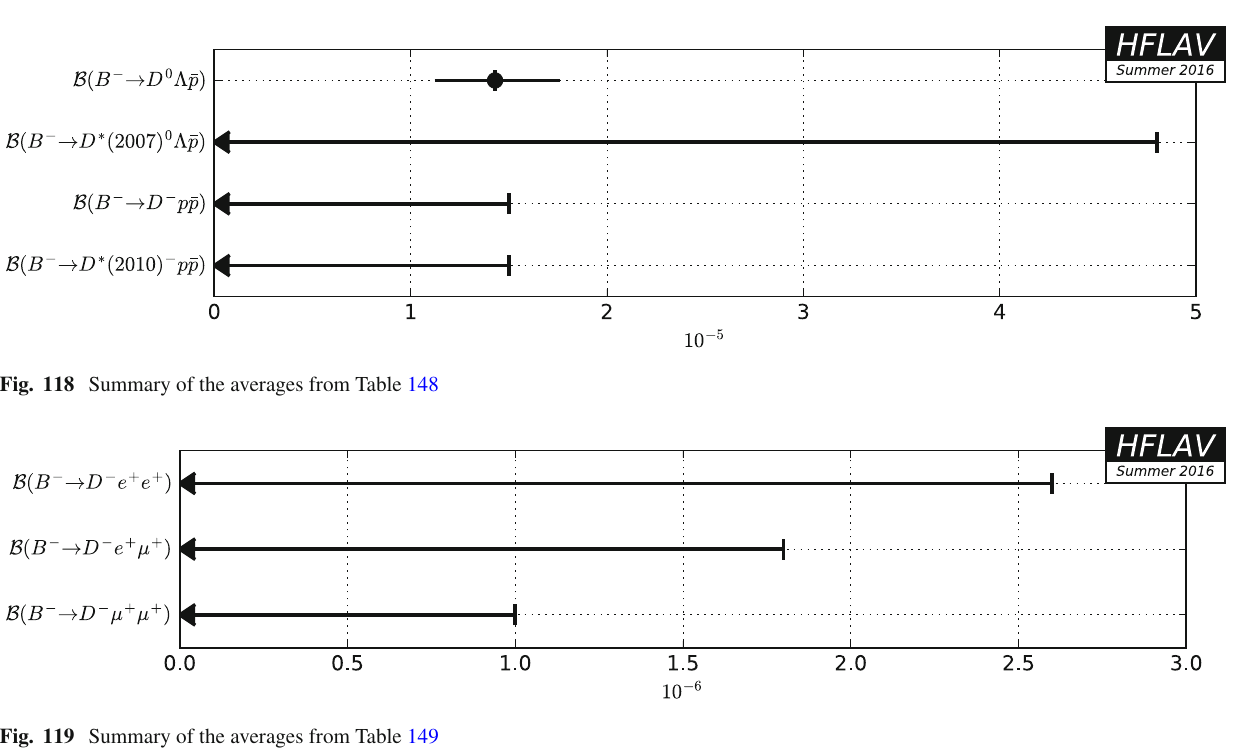
Fig. 117 Summary of the averages from Table 147